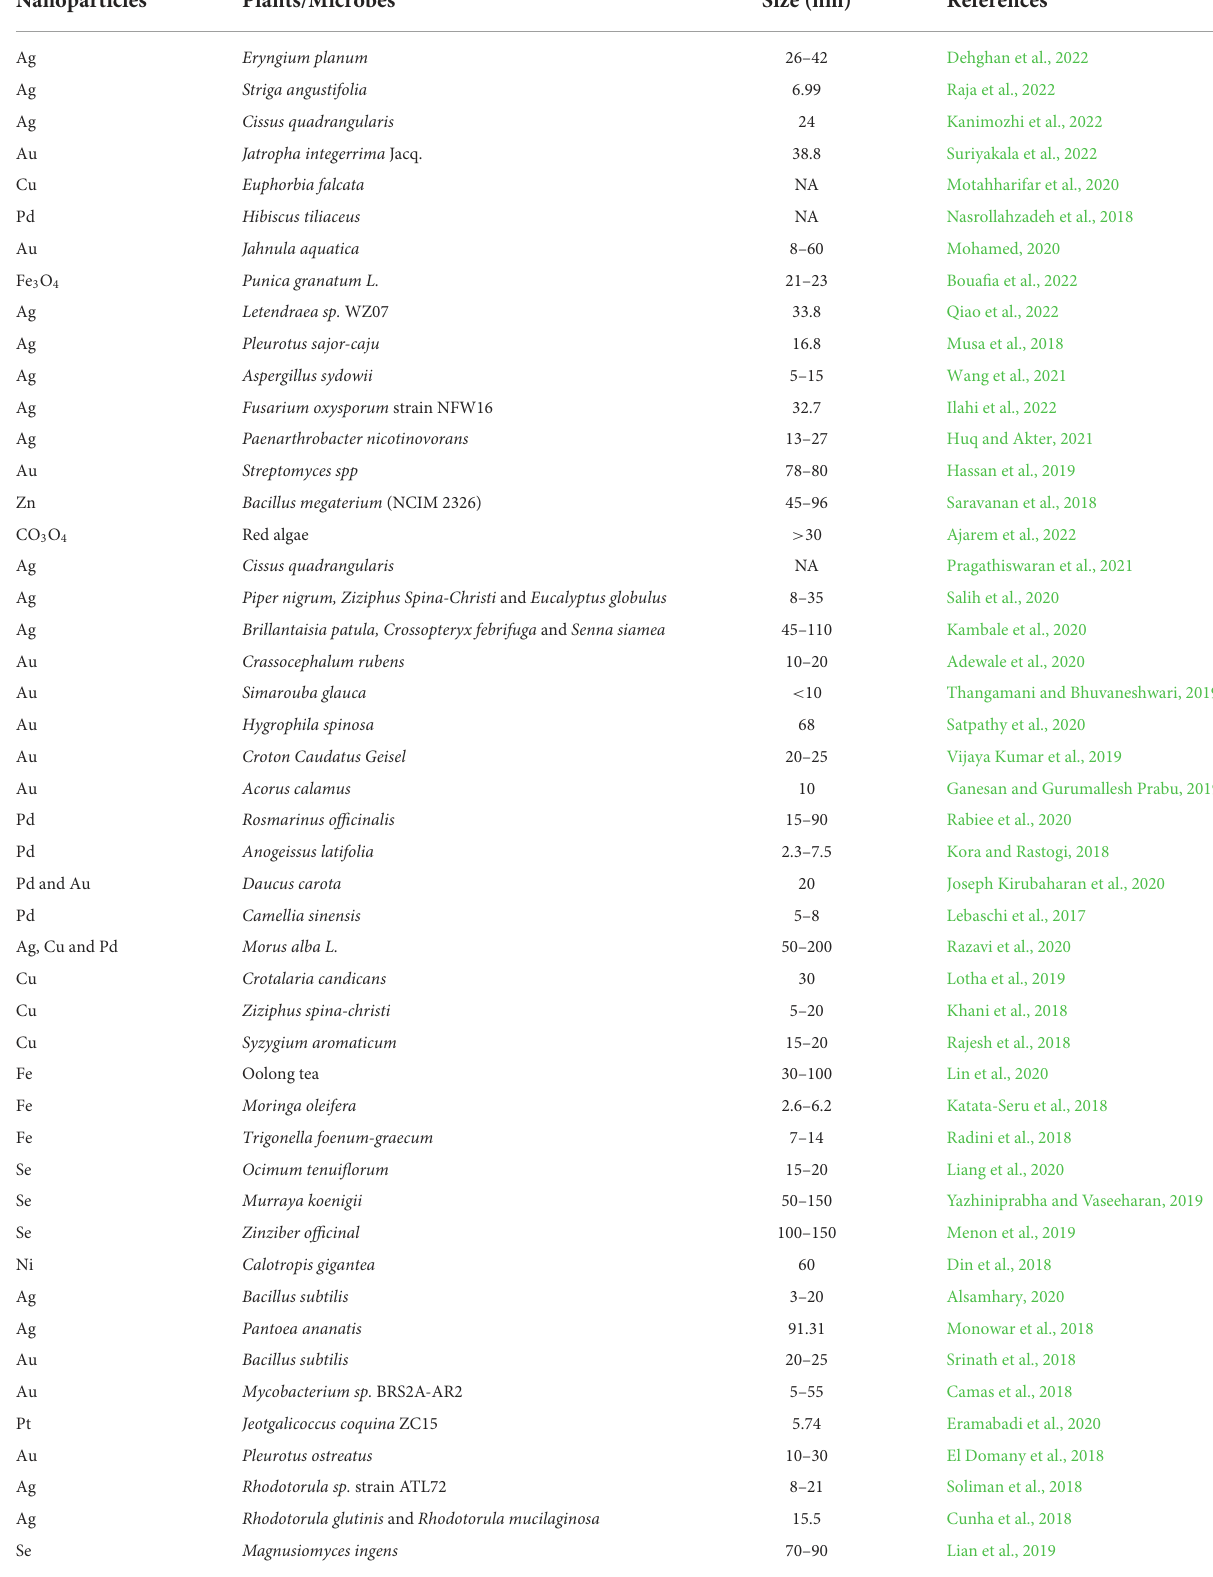
TABLE 1 Reported plants and microbes responsible for green synthesis of MNPs.